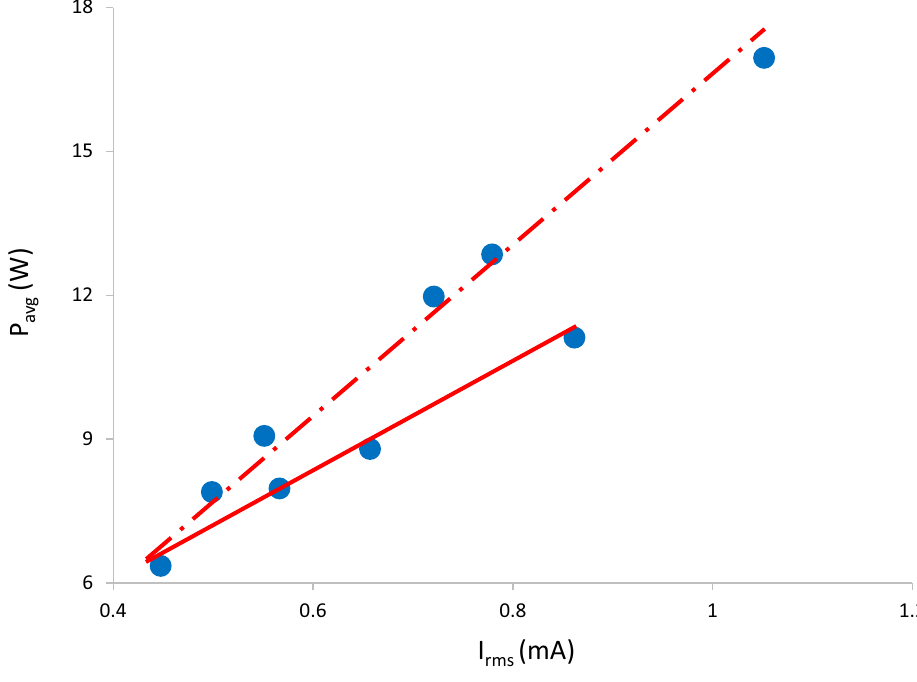
Figure 11. Measured power of typical plasma jets (solid) and JDBDs